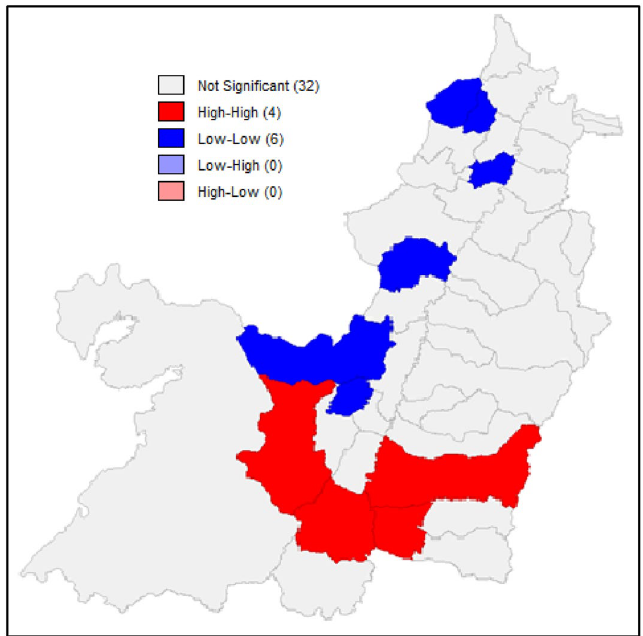
Fig. 7 Bivariate Moran Index between the 2014 fiscal efficiency and the population density. Source: own computation based upon GeoDa